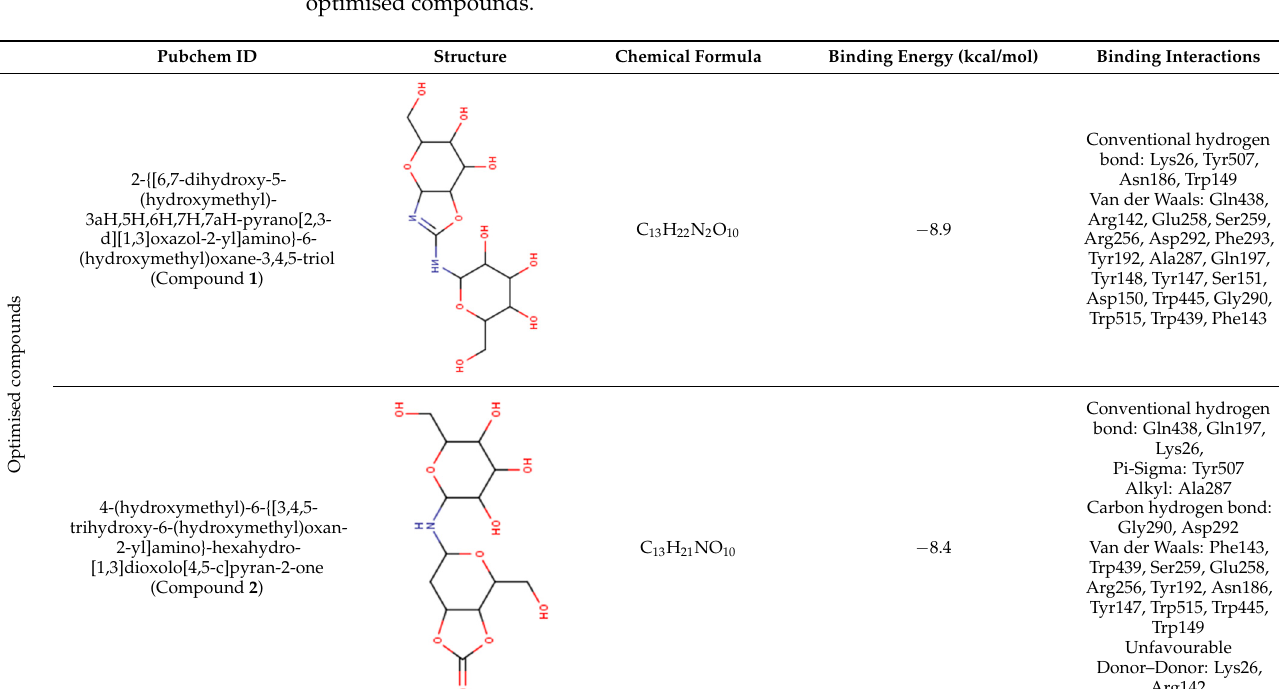
Table 5. Structure, chemical formula, binding energies, and binding interactions of Ag Tre with optimised compounds.